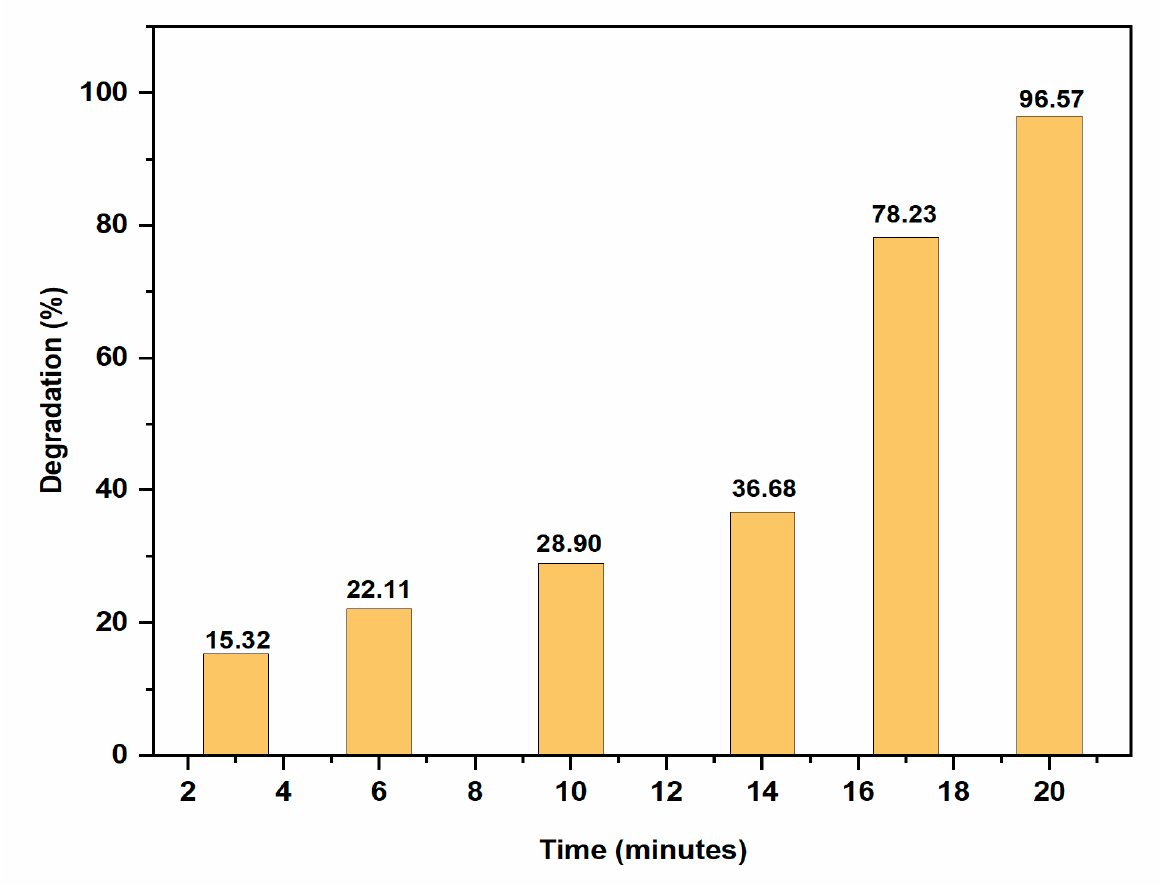
Figure 8. At 25 °C, successive UV–Vis absorbance spectra showing reduction of MB by NaBH reaction mixture without AgNPs ( b ) reaction mixture containing 0.5 mL of AgNPs ( c ) Smooth plots versus time for the degradation of MB at 25 °C. of ln A/A 0